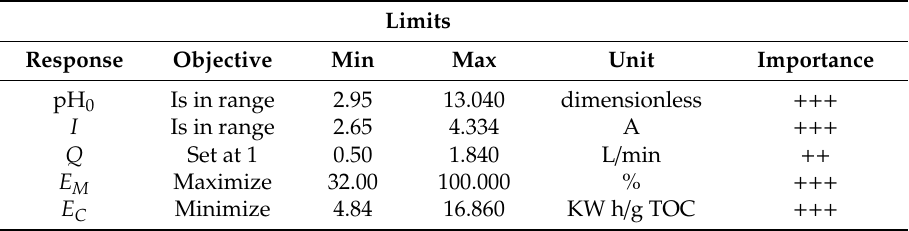
Table 6. Constrains criteria chosen for optimization of E M and E C